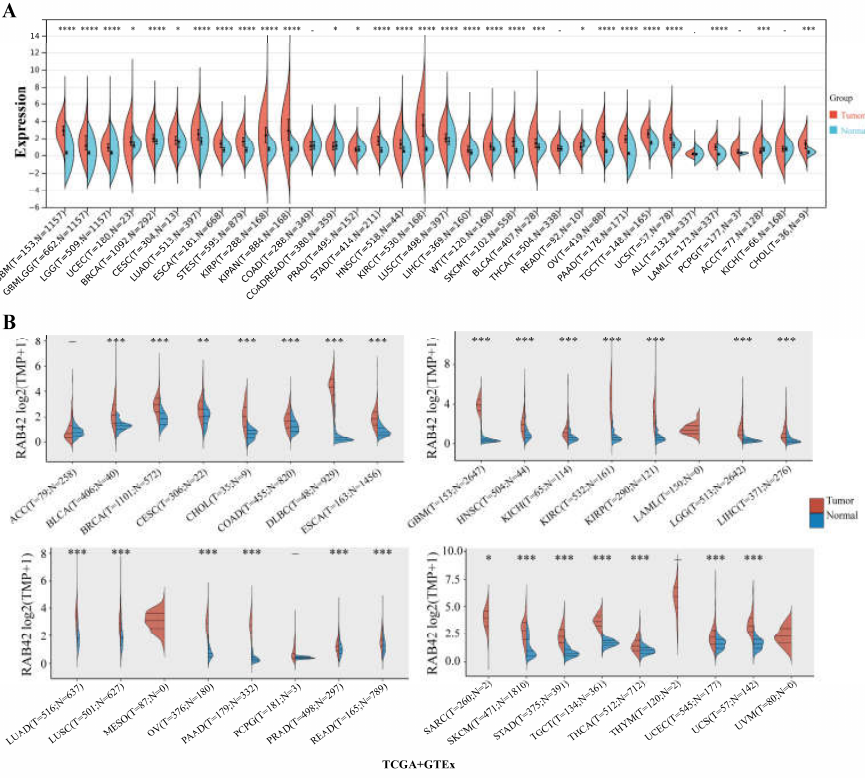
Figure 1. Expression analysis of RAB42 in pan-cancer. Comparison of RAB42 expression between normal and tumor tissues in the SangerBox ( A ) and ACLBI ( B ) databases. * p < 0.05, ** p < 0.01, *** p < 0.001, and **** p < 0.0001.